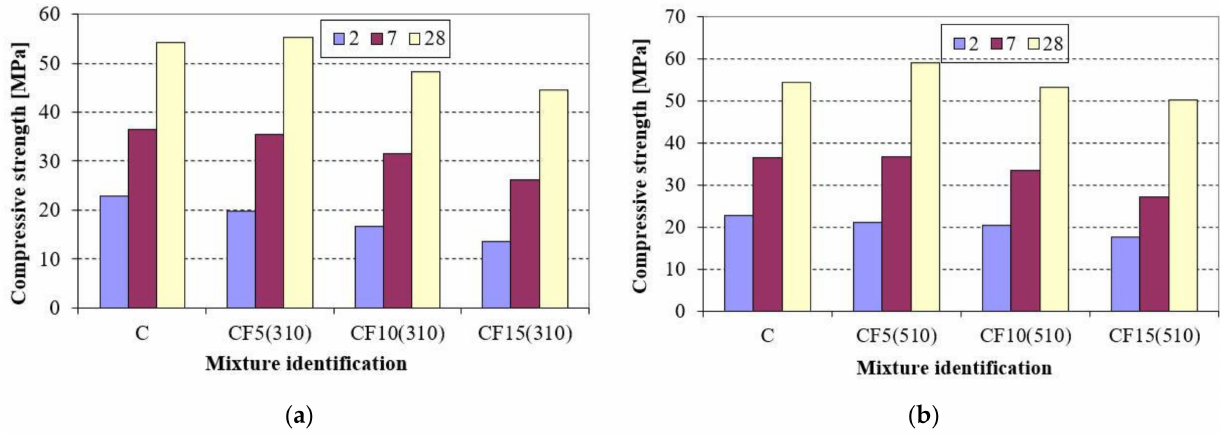
Figure 3. Compressive strength of Portland cements incorporating fly ash with specific surfaces of 310 m2/kg ( a ) and 510 m 2 /kg ( b